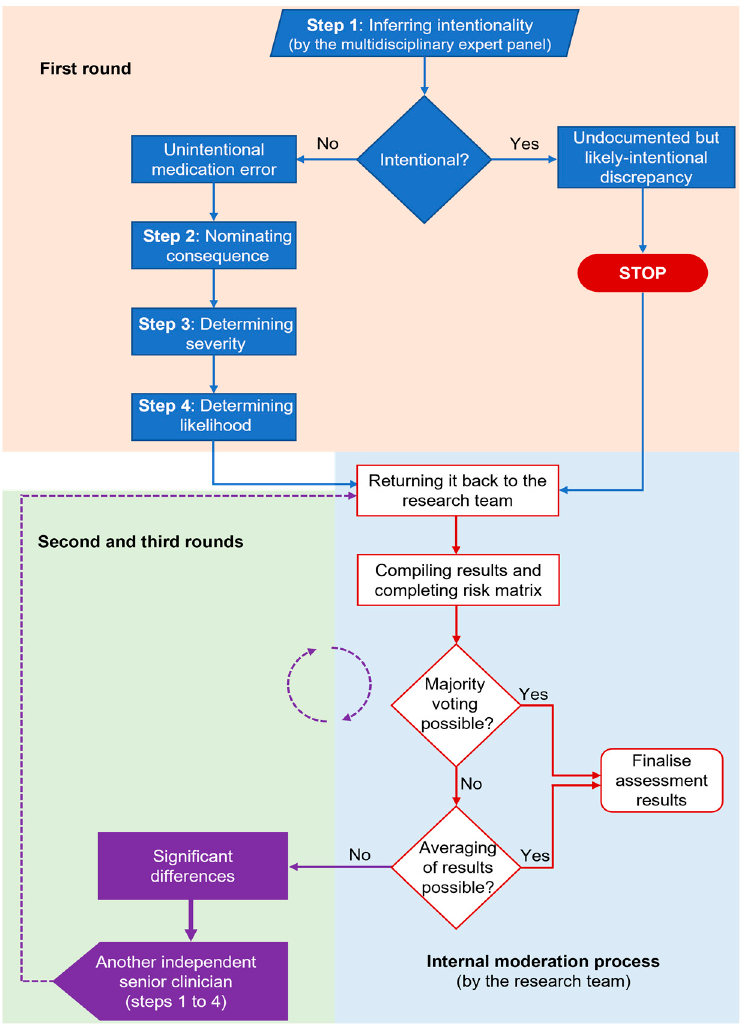
Figure 1. The panel assessment rounds and internal moderation process .